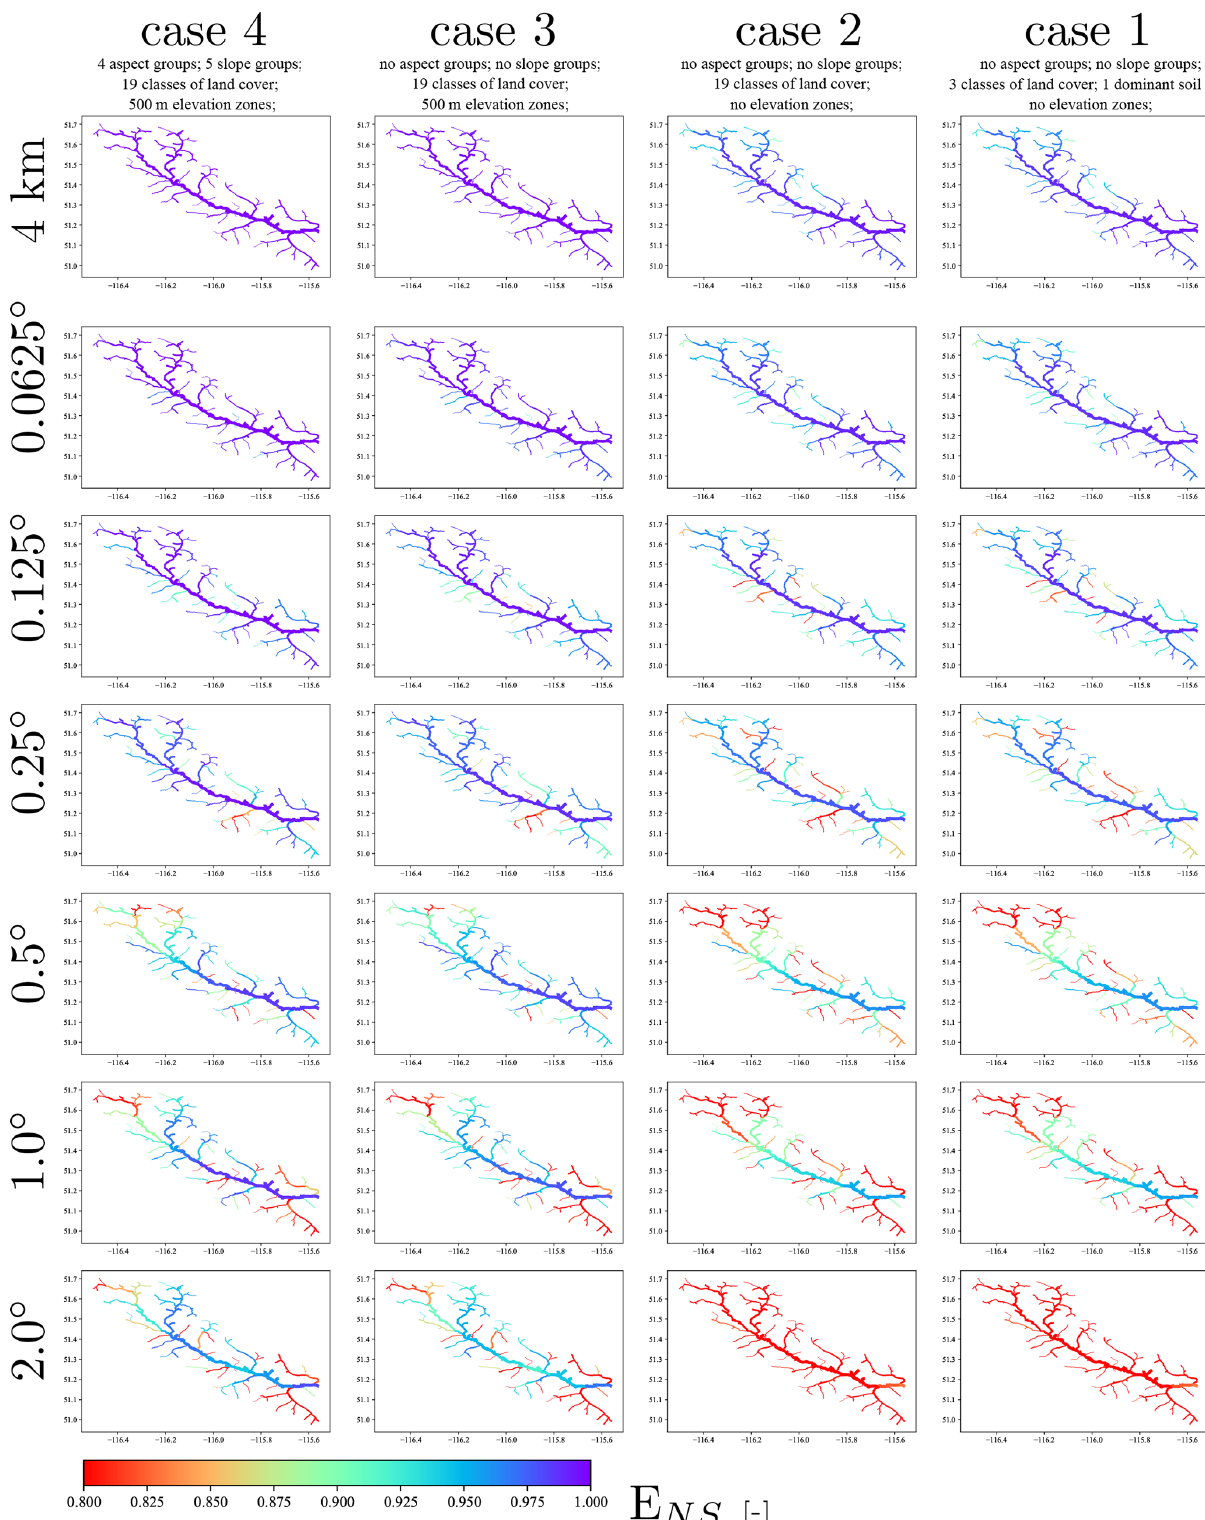
Figure 4. Differences of the simulated streamflow at river segments in comparison with the synthetic case, Case 4–4km, expressed in the performance metric E NS